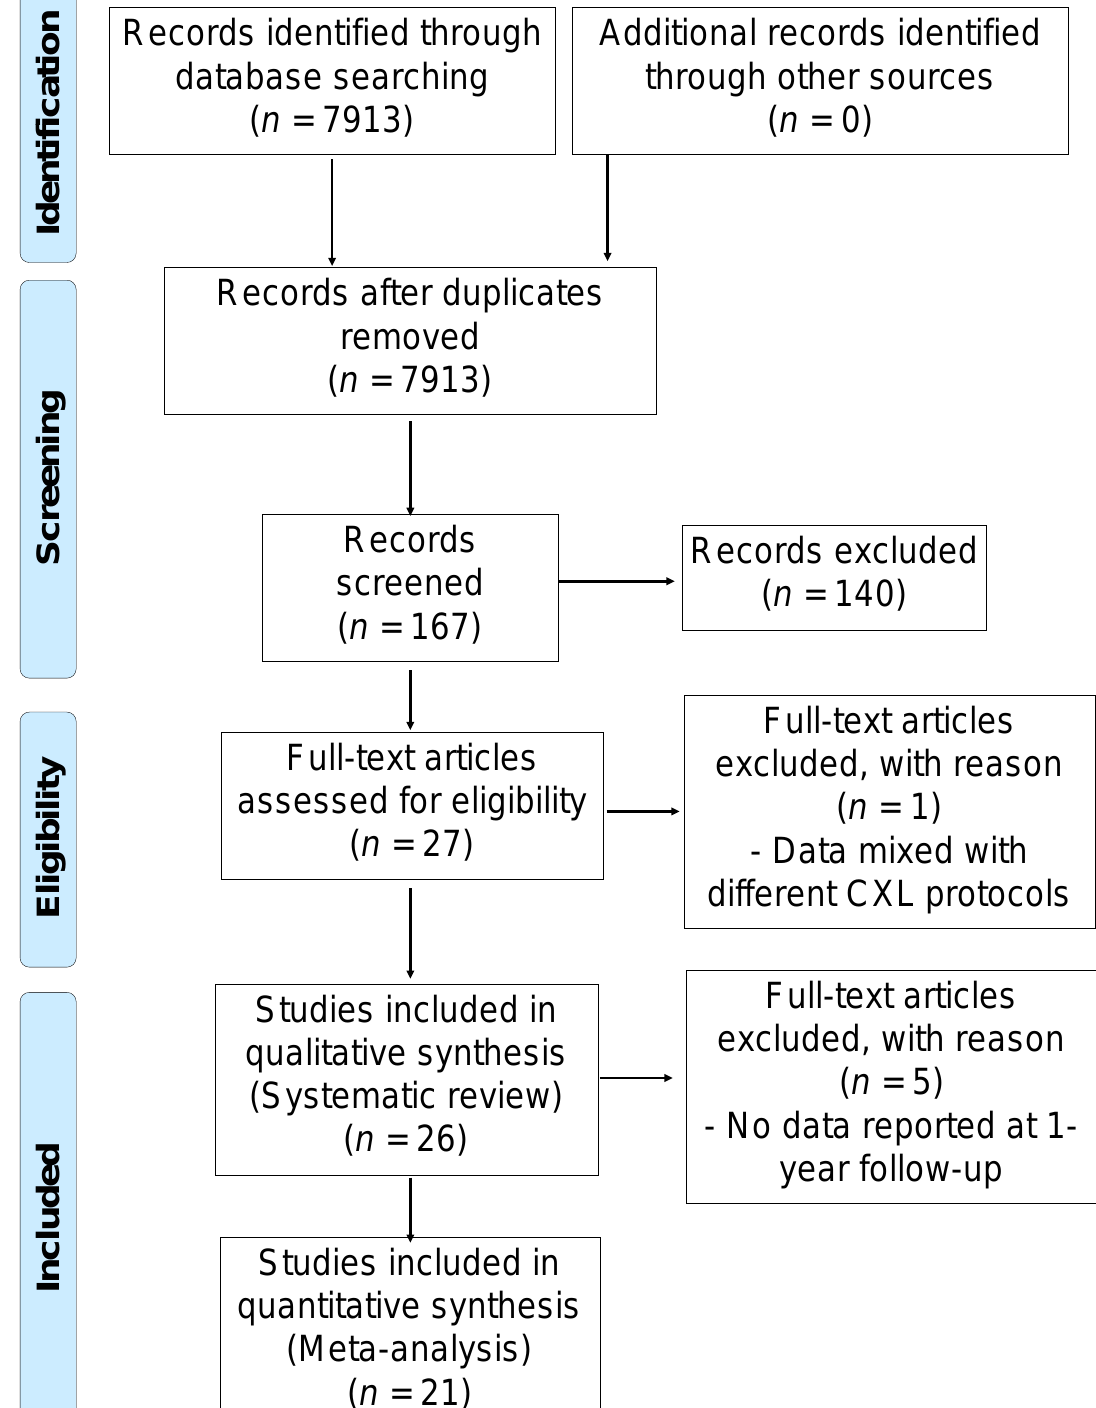
Figure 1. Preferred reporting items for systematic reviews and meta-analyses flow chart outlining search process to identify relevant articles from abstract identification to full paper review and inclusion of relevant